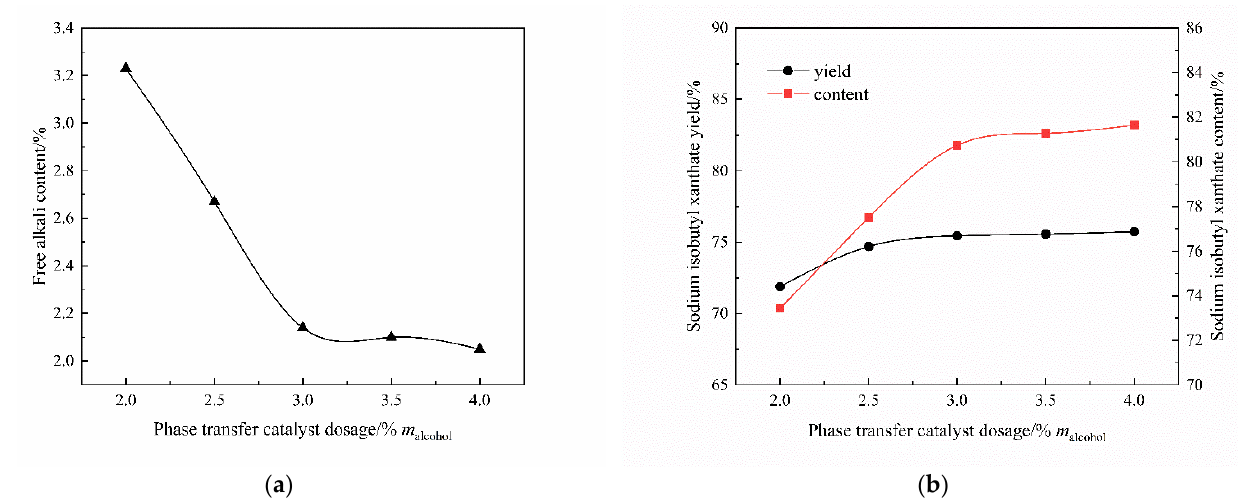
Figure 2. The effect of catalyst dosage: ( a ) The content of free alkali; ( b ) The content and yield of sodium isobutyl xanthate.